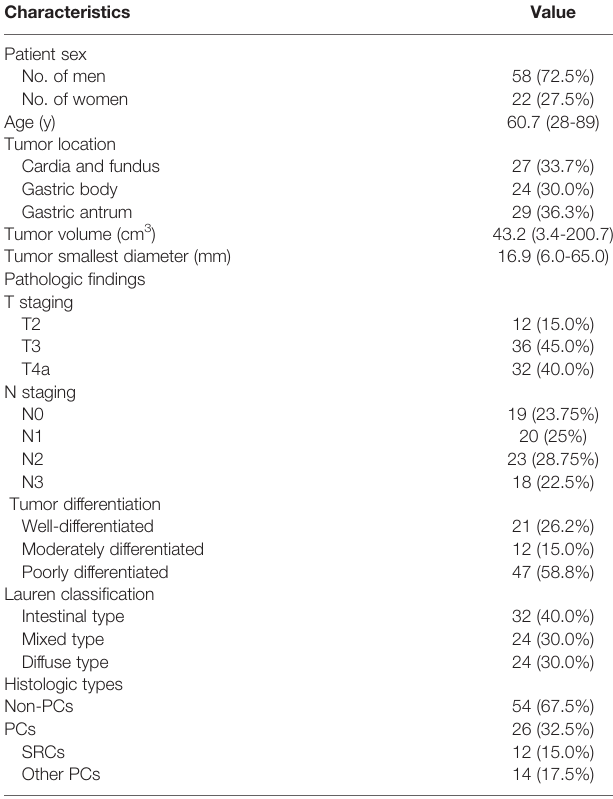
TABLE 2 | Baseline and demographic data in 80